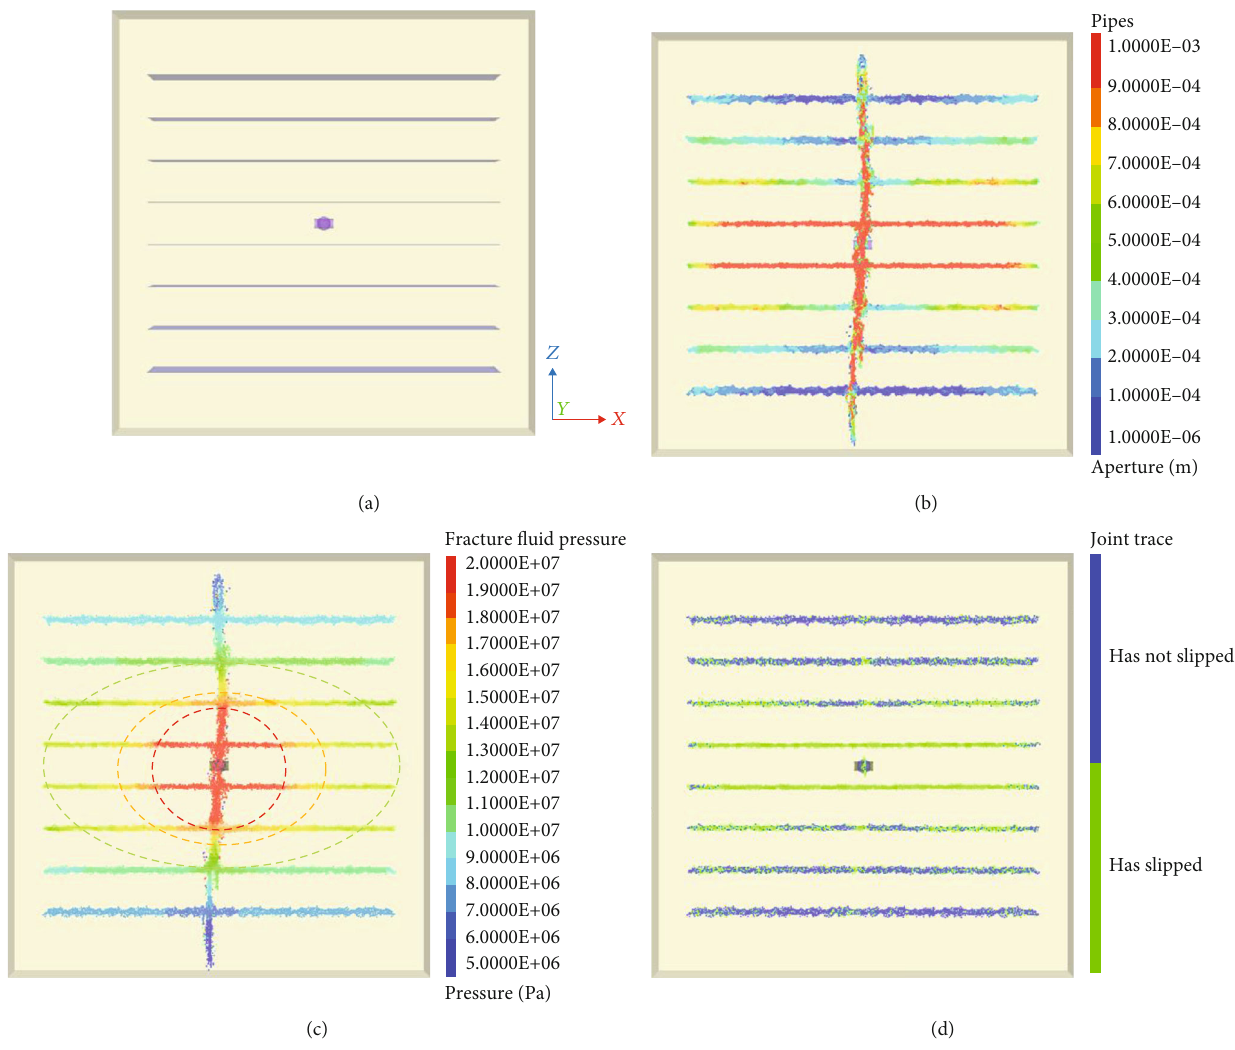
Figure 21: Type A NFN: (a) model setup, (b) fracture aperture, (c) fracture fl uid pressure, and (d) shear slip on the